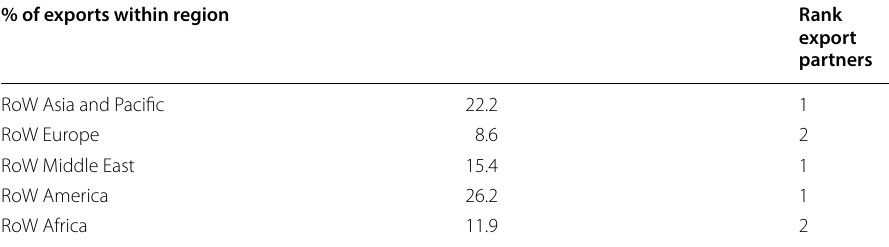
Table 1 Percentage of intra-RoW region exports for year 2015 % of exports within